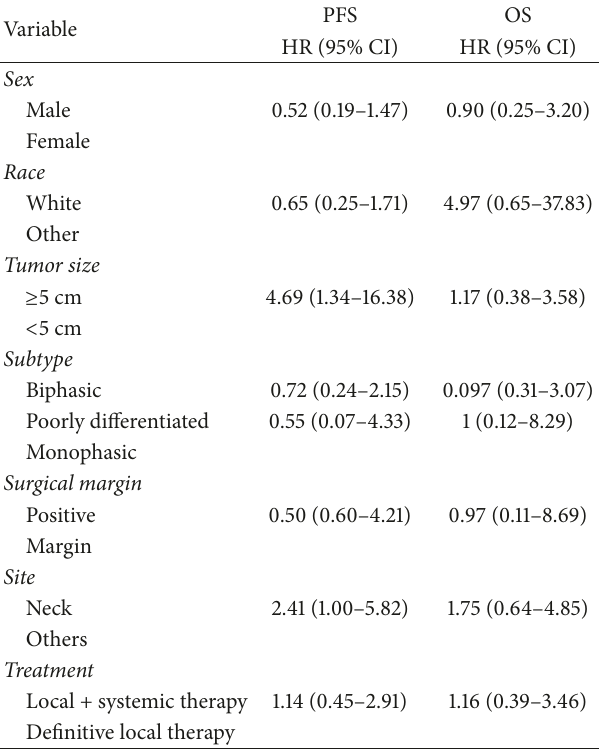
Table 3: Univariate Cox proportional-hazards model results.